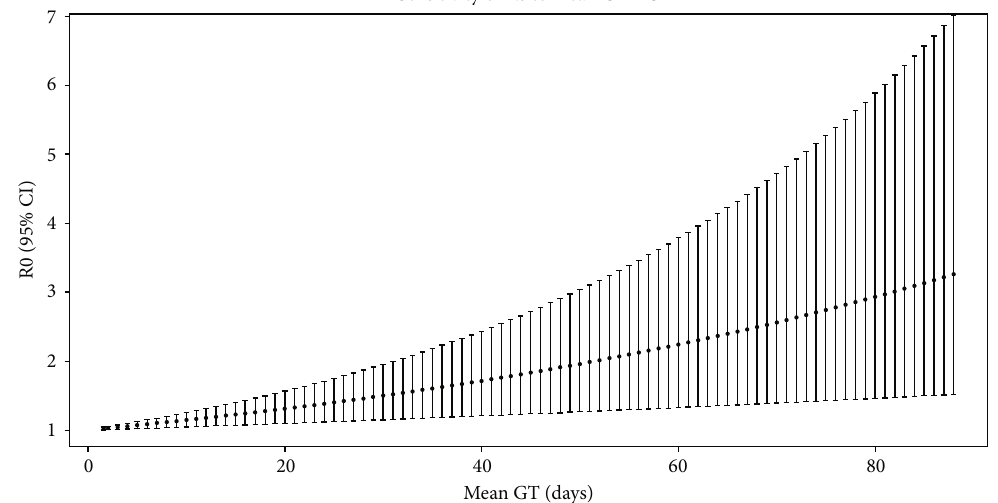
Figure 3: (a) Bifurcation diagram of system (2). The epidemiological importance of the existence of bifurcation especially a backward bifurcation in meningitis transmission model depicts that the classical requirement of having the basic reproduction number R although necessary, is not su ffi cient for controlling the meningitis disease. (a) Backward bifurcation occurs in system (2) for a = 0 : 25 and β = 0 : 4 , and (b) forward bifurcation will be achieved for a = 0 : 87 and β = 0 : 004 .